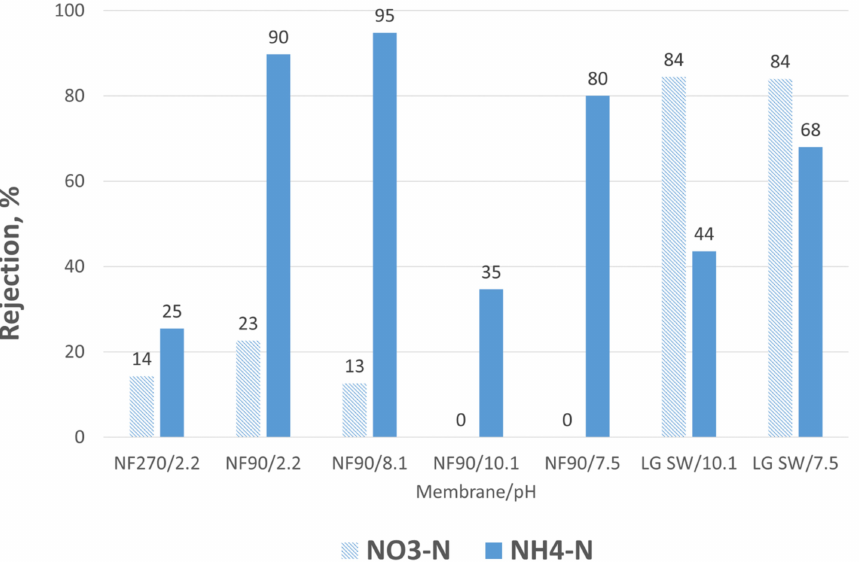
Figure 4. Nitrate nitrogen (NO 3 -N) and ammonium nitrogen (NH 4 -N) rejections using different pre-treatment and